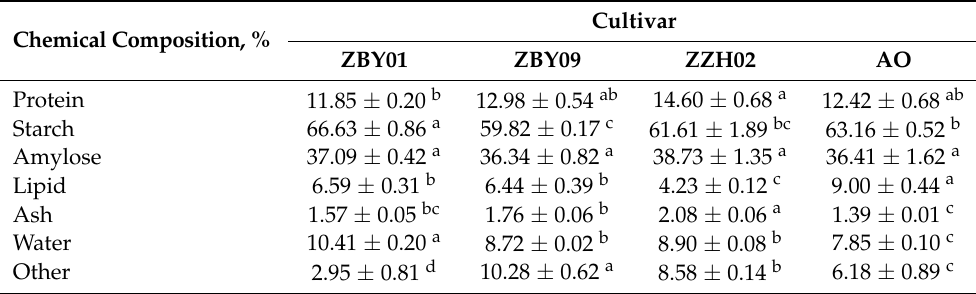
Table 2. Chemical composition of oat cultivars.